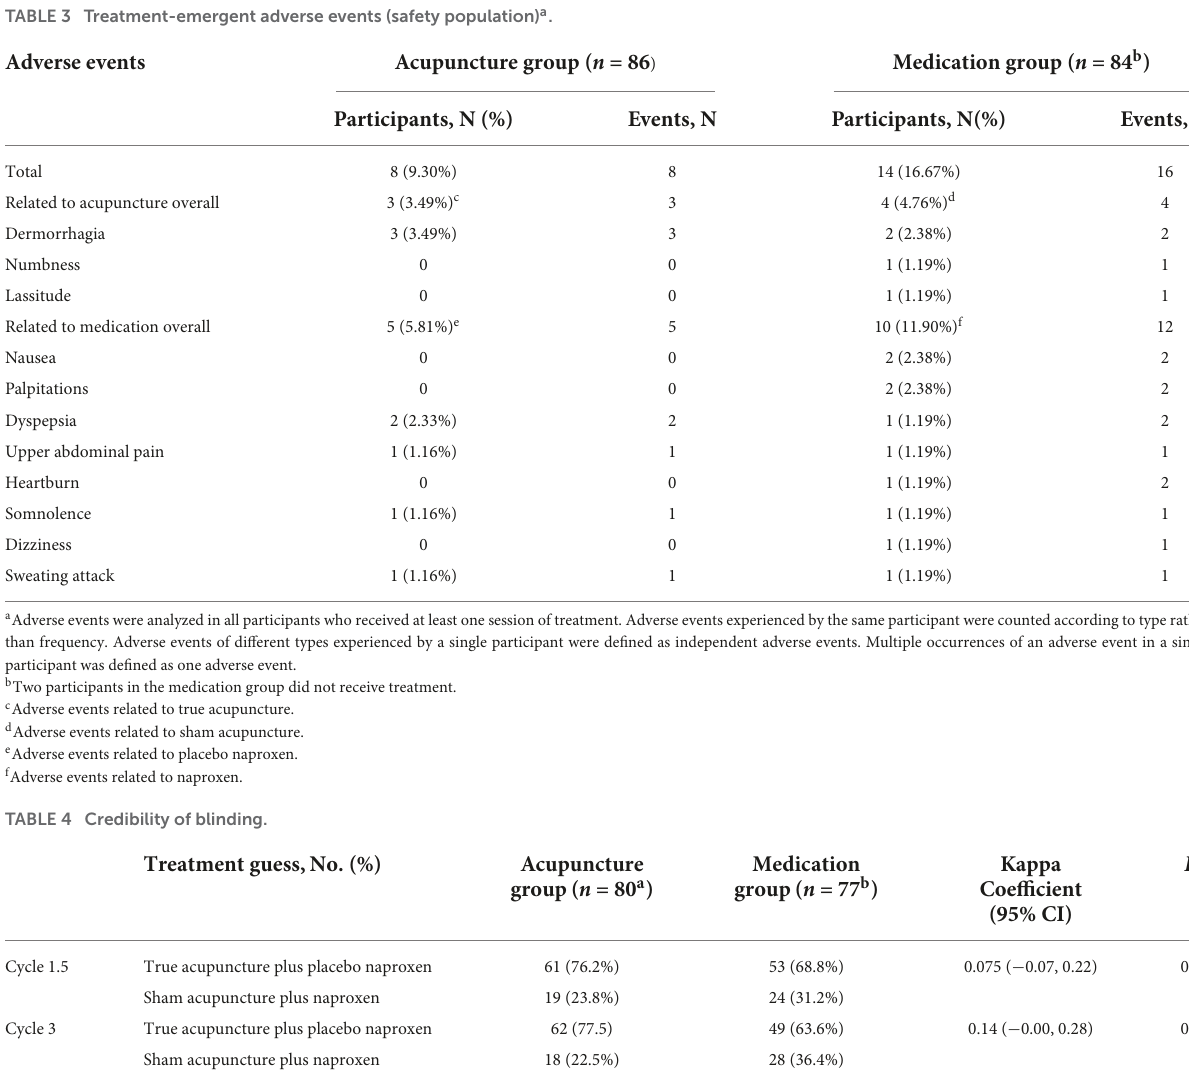
TABLE 3 Treatment-emergent adverse events (safety population) a .